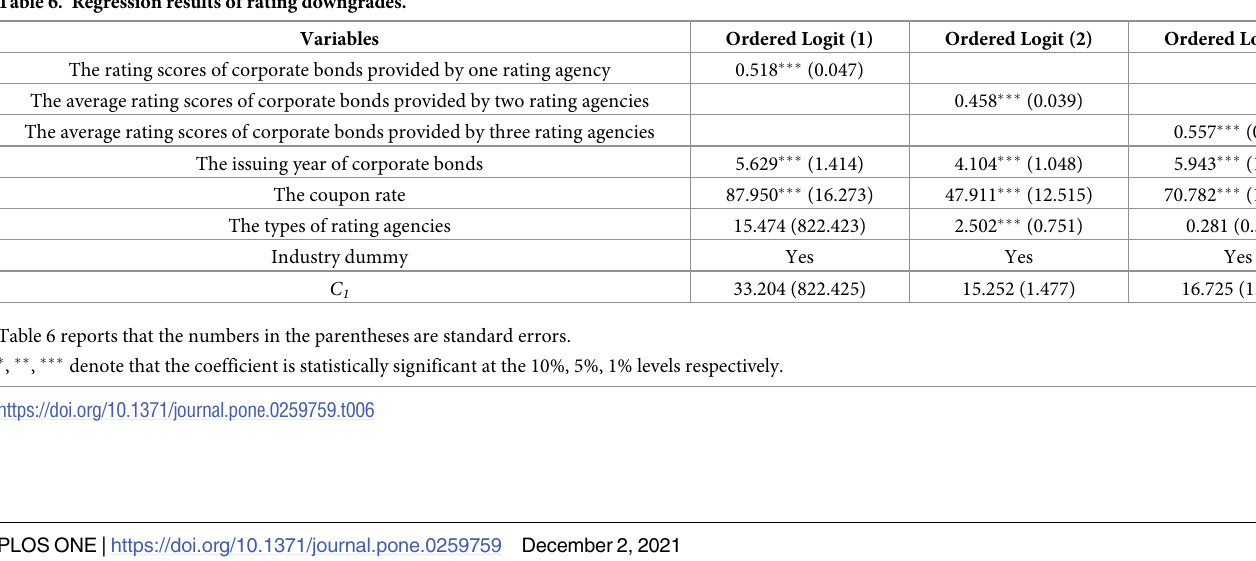
Table 6 reports the effects of the single, dual, and multi-rating regulation on rating down- grades. In the Column 1 model, the coefficient of the rating scores provided by one rating agency is significantly positive in S1 Data. In the Column 2 model, the coefficient of the aver- age rating scores provided by two rating agencies is significantly positive in S2 Data. In the Column 3 model, the coefficient of the average rating scores provided by three rating agencies is also significantly positive in S3 Data. Additionally, the coefficient of the average rating scored provided by two rating agencies is the smallest. The results suggest that the three rating regulations are effective in decreasing rating deflation. Based on Tables 5 and 6, the regulatory effects of the dual-rating regulation is the best and rating agencies can improve rating quality under this regulation.